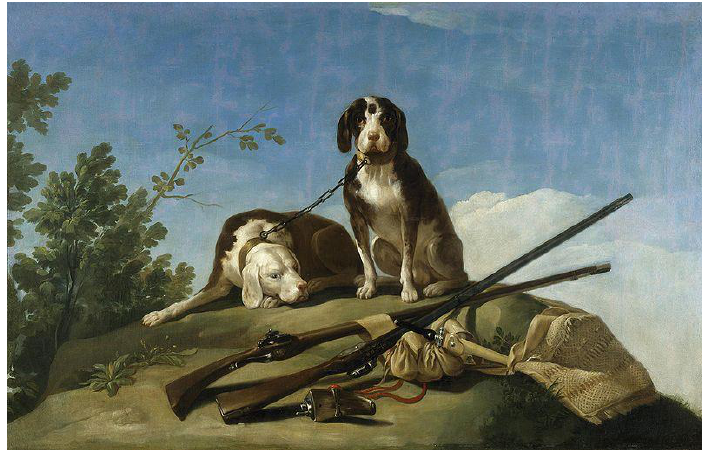
Figure 2. Francisco de Goya, Perros y útiles de caza o Perros en traílla (1775). Oil on canvas. 112 × 174 cm. Museo del Prado (Madrid, España) Public domain (Goya 1775). Museo del Prado (Madrid, España) Public domain (Goya 1775).